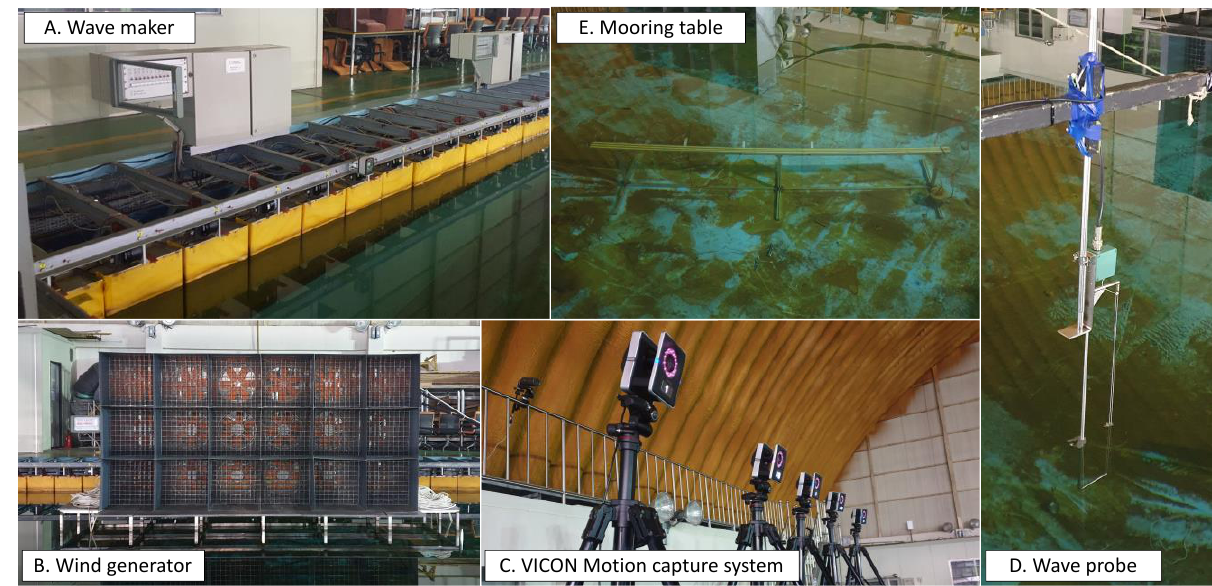
Figure 4. Experiment equipment and sensors. Table 5. Load cases for model test and numerical simulation.